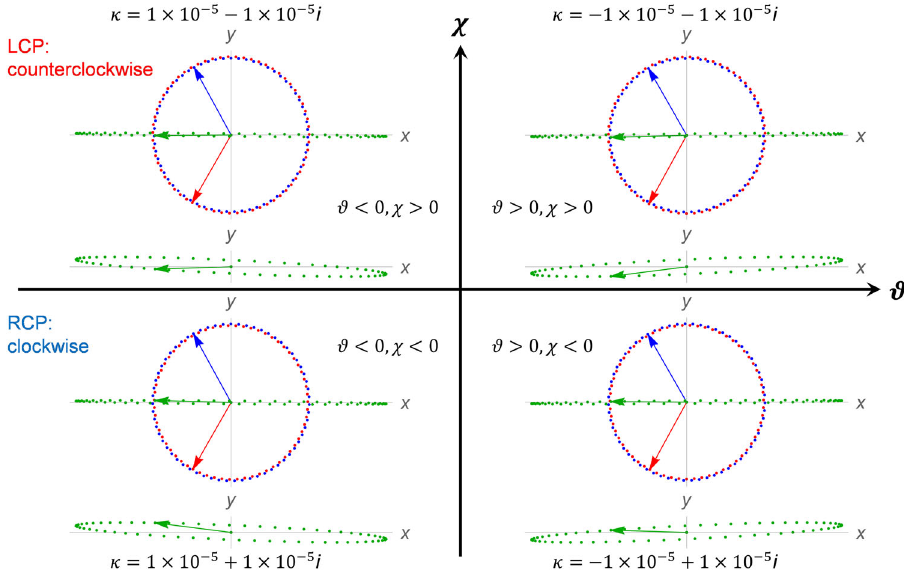
Fig. 6 Circular basis representation of the elliptically polarized transmitted beam ( c + e + + c − e − ). Four possible combinations of the complex-valued chirality parameter κ are considered and the results are shown in four different quadrants in the plane of optical rotation ϑ and ellipticity angle χ . The radius of the red (blue) dotted circle denotes the absolute value of the complex transmitted wave c + ( c − ) expressed in terms of the unit circular basis vectors e + ( e − ), where the + ( − ) sign in the subscript indicates LCP and (RCP) states, respectively. The angle between the positive x -axis and the red (blue) colored arrow that represents the electric- fi eld vector c + e + ( c − e − ) at time t = 0 signi fi es the initial phase of c + ( c − ). The red and blue colored arrows rotate in the counterclockwise (LCP) and clockwise (RCP) direction, respectively, as the beam propagates along the positive z direction. The superposition of c + e + and c − e − generates an elliptically polarized light (green dotted ellipse) and the direction of rotation of the green-colored arrow is the same as that of the circular component with a larger radius. For visibility purposes, the green dotted ellipses are redrawn with an aspect ratio of 1:10 ( x : y ) shown at the bottom of each panel. (Supplementary Note 13 and Supplementary Movie 1 for